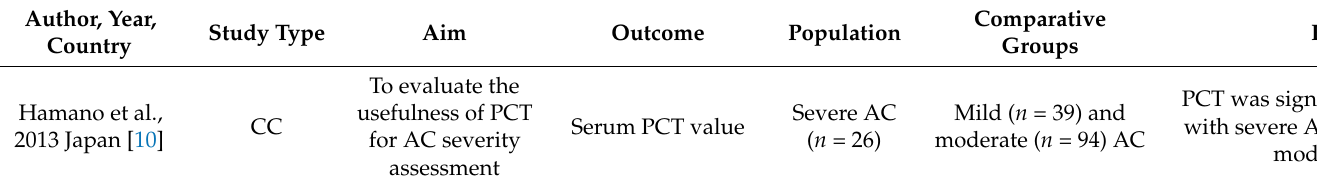
Table 1. Main characteristics of the included studies in the scoping